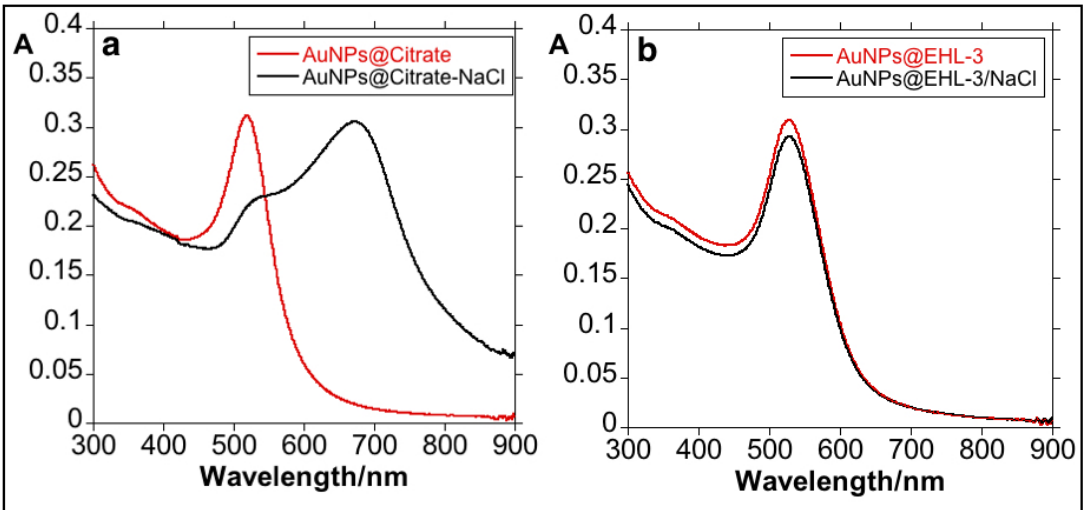
Figure 5. UV-Vis study of the effects of adding of 200 L NaCl 2 M to 3 mL of AuNPs@Citrate ( a ) and AuNPs@EHL-3 ( b ); dilution factor 1:10.